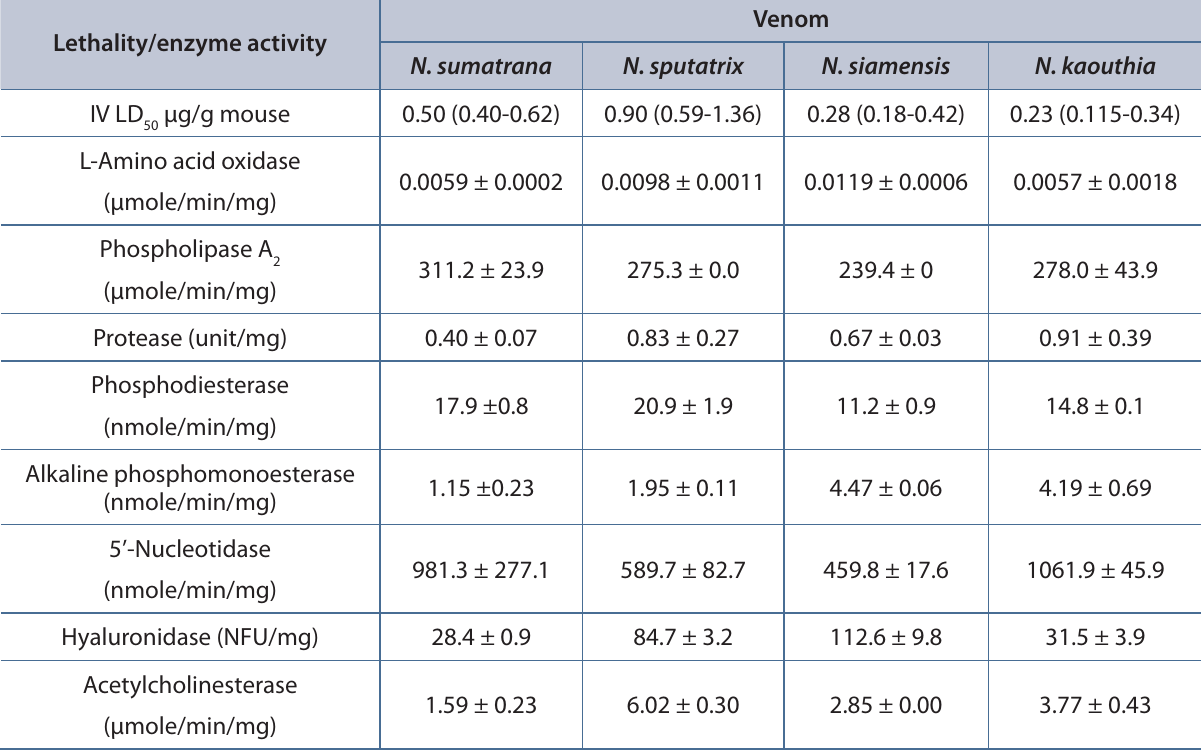
Table 1. Lethal and enzymatic activities of four Asiatic cobra venoms Lethality/enzyme